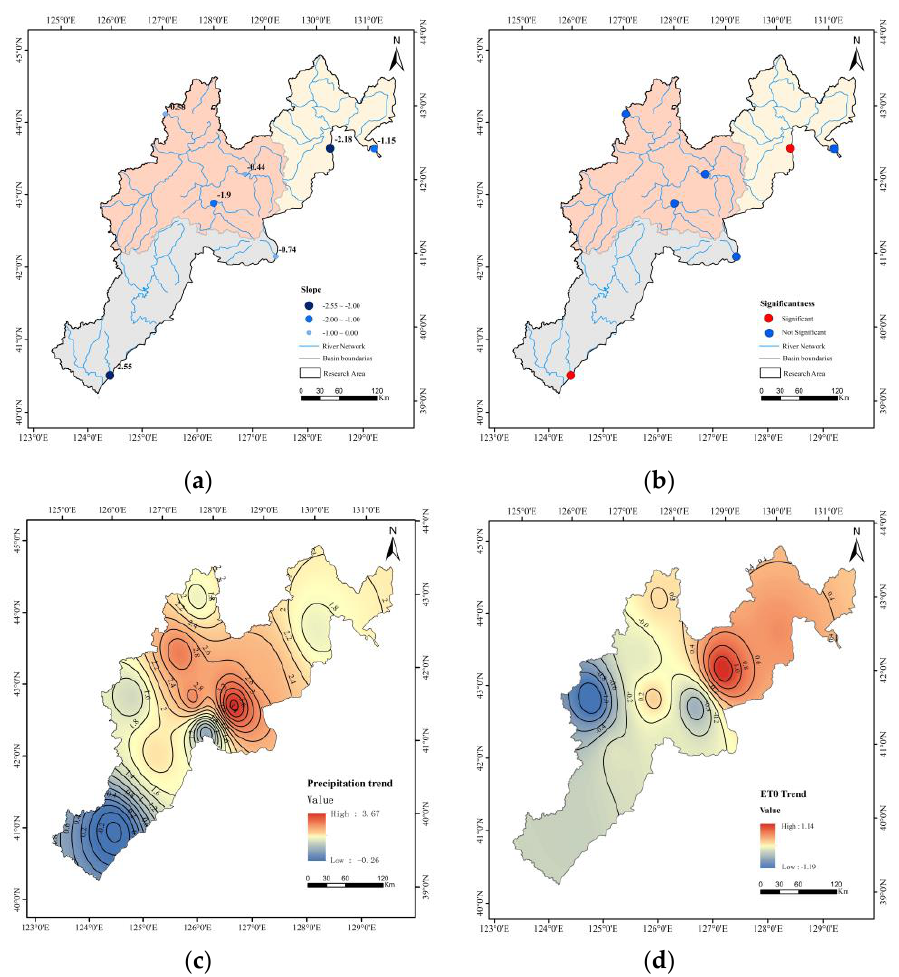
Figure 2. Results of Sen’s slope estimator for partitions of the Changbai Mountain area. ( a , b ) show the trend and significance of the runoff, ( c , d ) show the trend of the precipitation and the potential evapotranspiration.